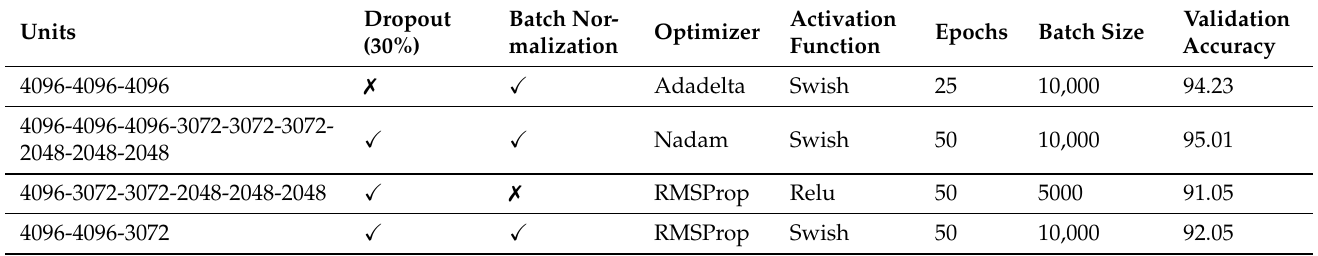
Table 3. Comparison of a few models which were used for the temperature